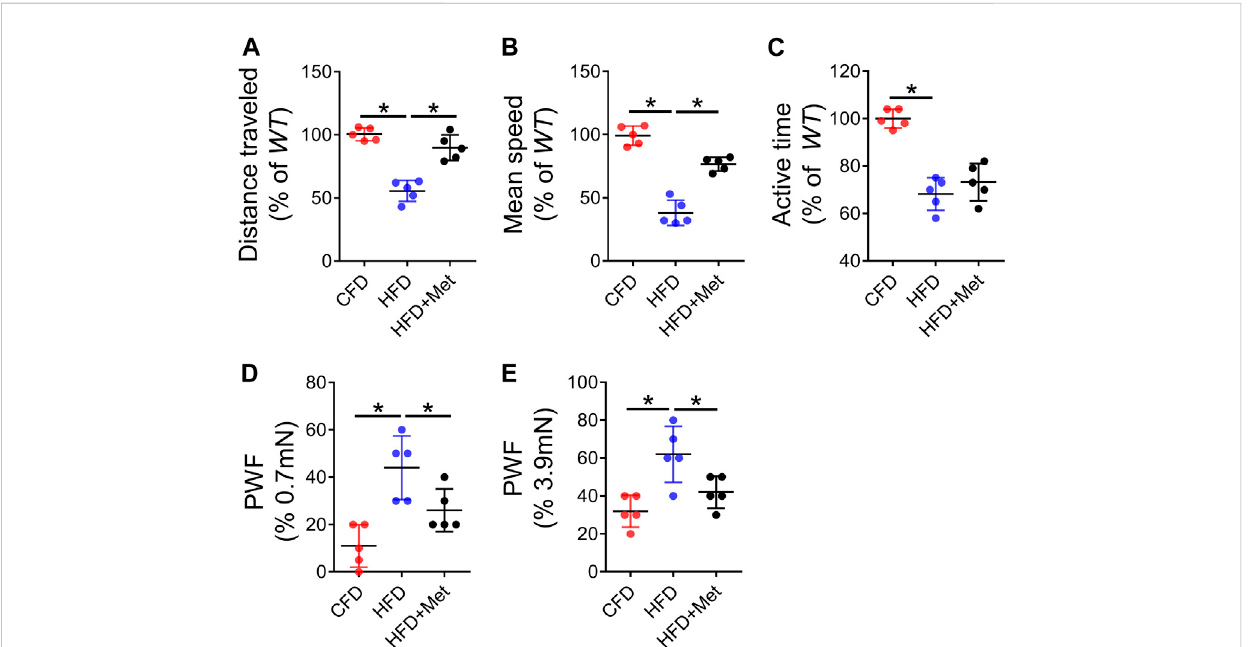
FIGURE 6 Metformin rescues HFD induced OA pain. (A – C) Parameters of voluntary wheel running for mice which were fed a standard chow-food diet (CFD), HFD, or HFD with metformin (HFD + Met): distance traveled (A) , mean speed (B) , and active time (C) ; n = 5 mice per group. (D – E) Parameters of von fray test for mice which were fed a standard chow-food diet (CFD), HFD, or HFD with metformin (HFD + Met): paw withdraw frequency (PWF) at 0.7 mN stimulation (D) and PWF at 3.9 mN stimulation (E) . All data are shown as means ± standard deviations. * p < 0.05. Statistical signi fi cance was determined by one-way